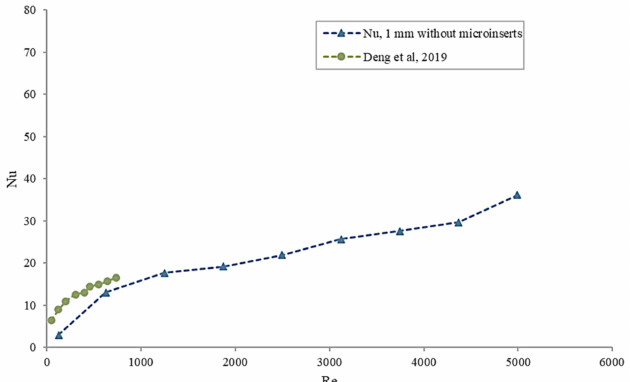
Figure 9. Comparison of the results with the available data (without